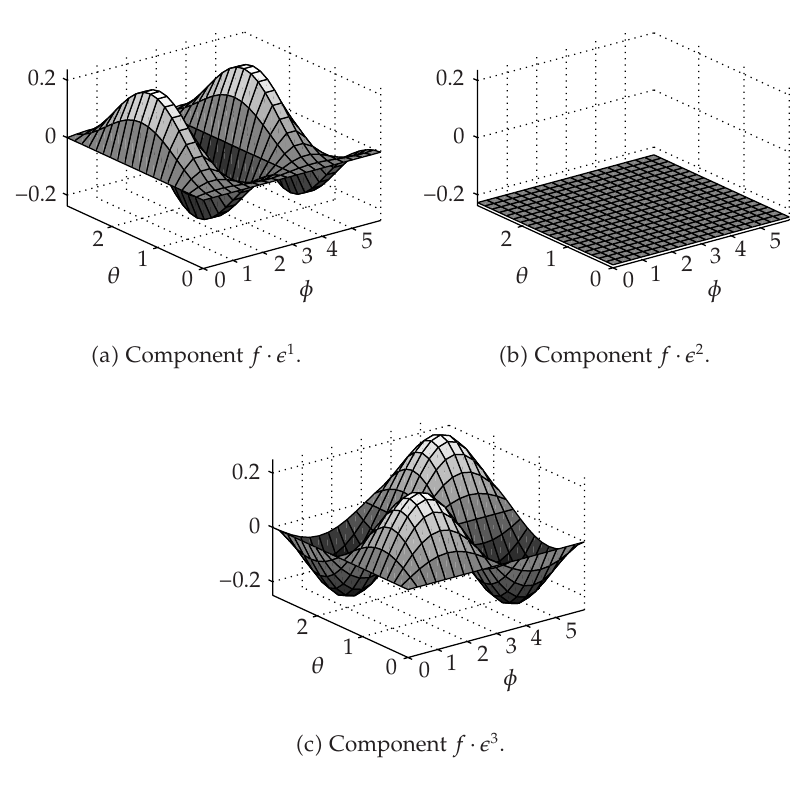
Figure 6.7 . Exact displacements in Cartesian components on Ω